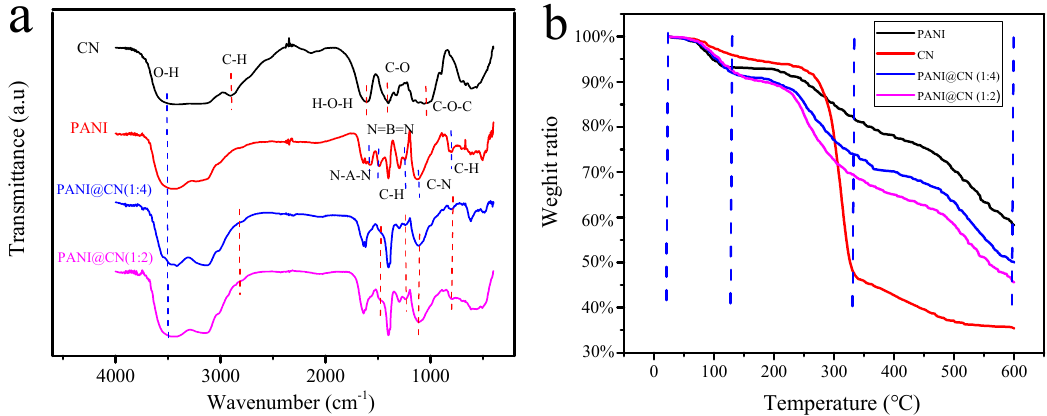
Figure 4. ( a ) FT-IR spectra of CNs, PANI, and PANI@CNs with the different weight ratios of CNs/aniline; ( b ) TGA curves of CNs, PANI@CNs, and PANI.